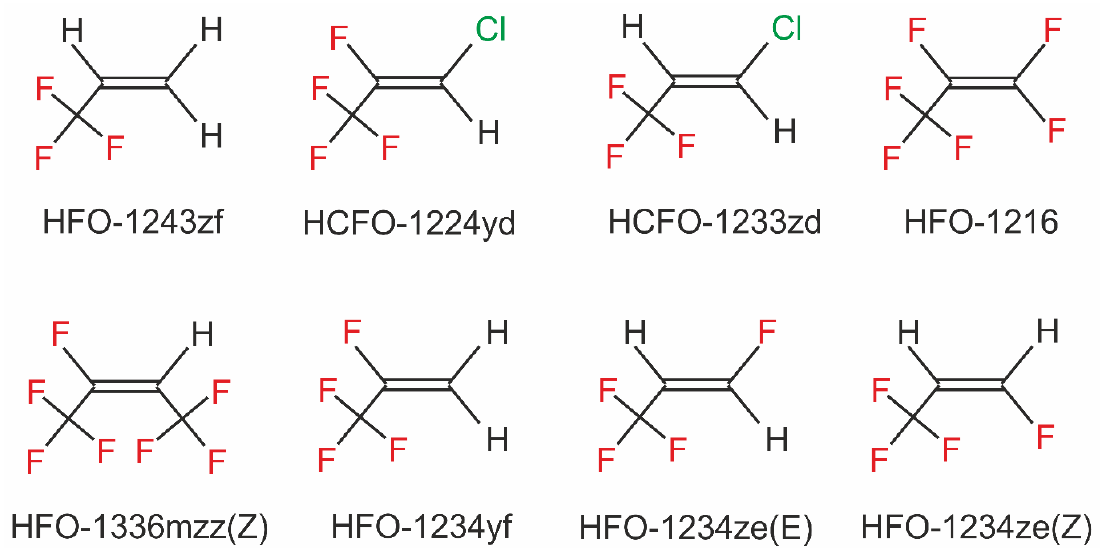
Figure 1. Structural formula of hydrofluoroolefins (HFO) and hydrochlorofluoroolefin (HCFO) refrigerants.